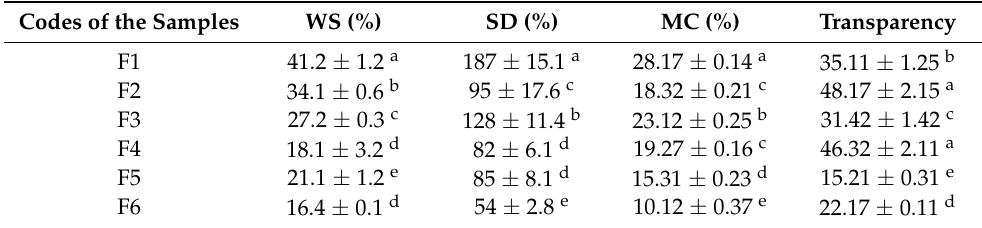
Table 3. WS, SD, MC, and transparency of the edible films. Codes of the